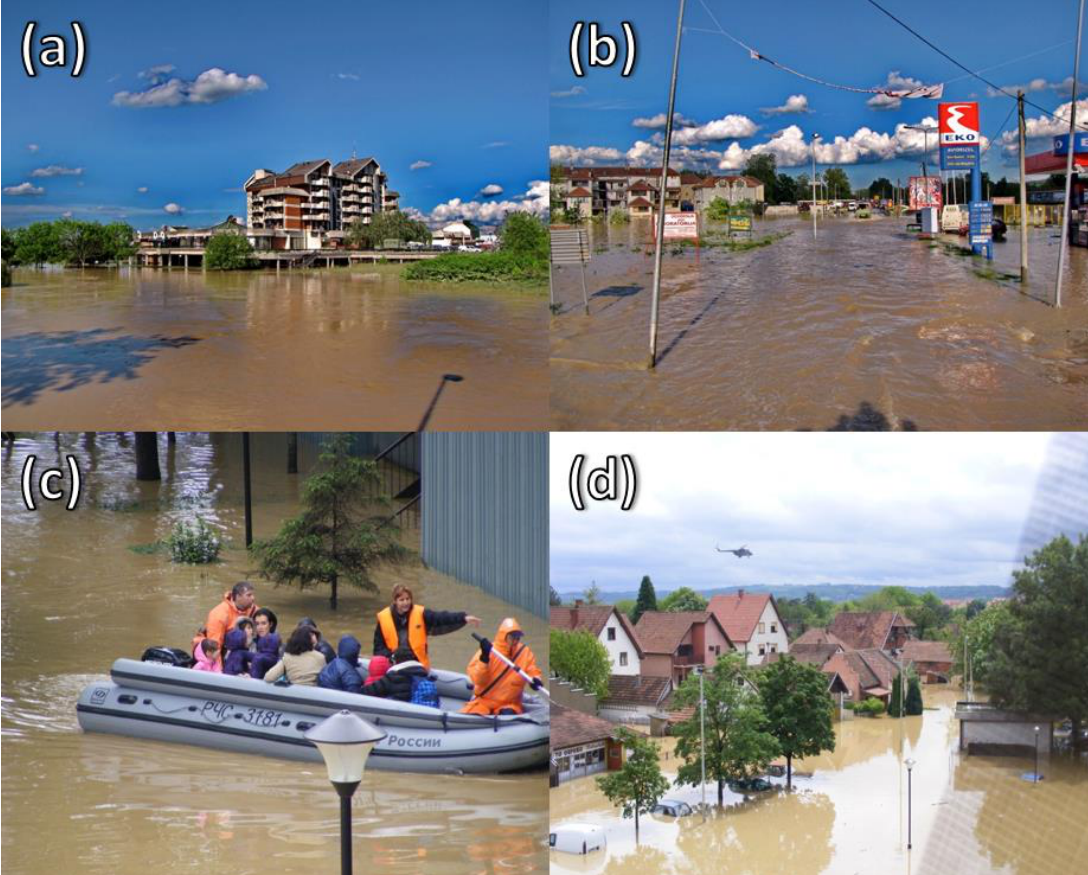
Figure 2. The most critical flood event occurred in 2014 in Serbia. ( a ) flooded hotel in Obrenovac; ( b ) flooded streets in Obrenovac; ( c ) citizen evacuation in Obrenovac; ( d ) rescue helicopter in Obrenovac.